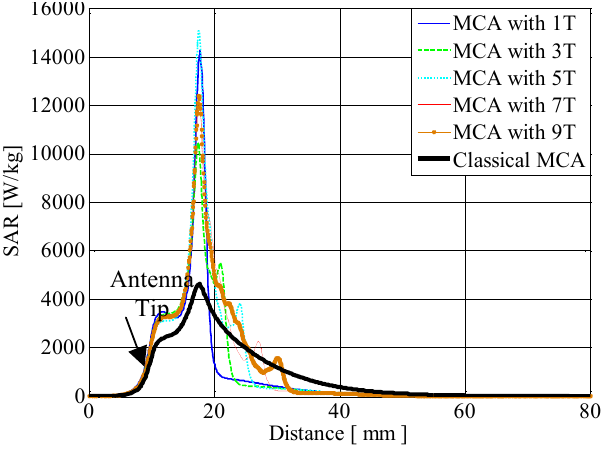
Figure 5: SAR distribution along the MCA at 2.5 mm The effect of the T-ring shape structure on the antenna radiation pattern is more clearly apparent in 2D representation.